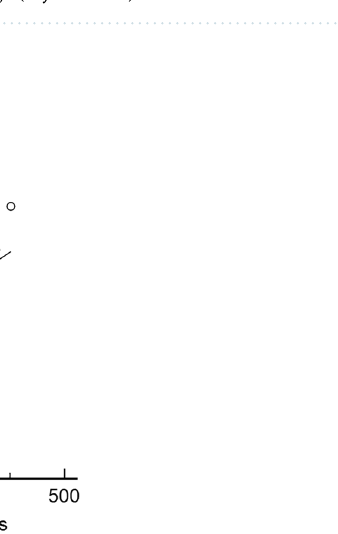
Figure 4. Example of three patients with disc hemorrhage. Disc photographs ( a , f , k ) and laser Doppler images before ( b , g , l ) and 1 ( c , h , m ), 10 ( d , i , n ), and 20 ( e , j , o ) minutes after the cold stimulus of patients with high- tension disc hemorrhage ( a – e ) and low-tension disc hemorrhage ( f–j and k – o ).